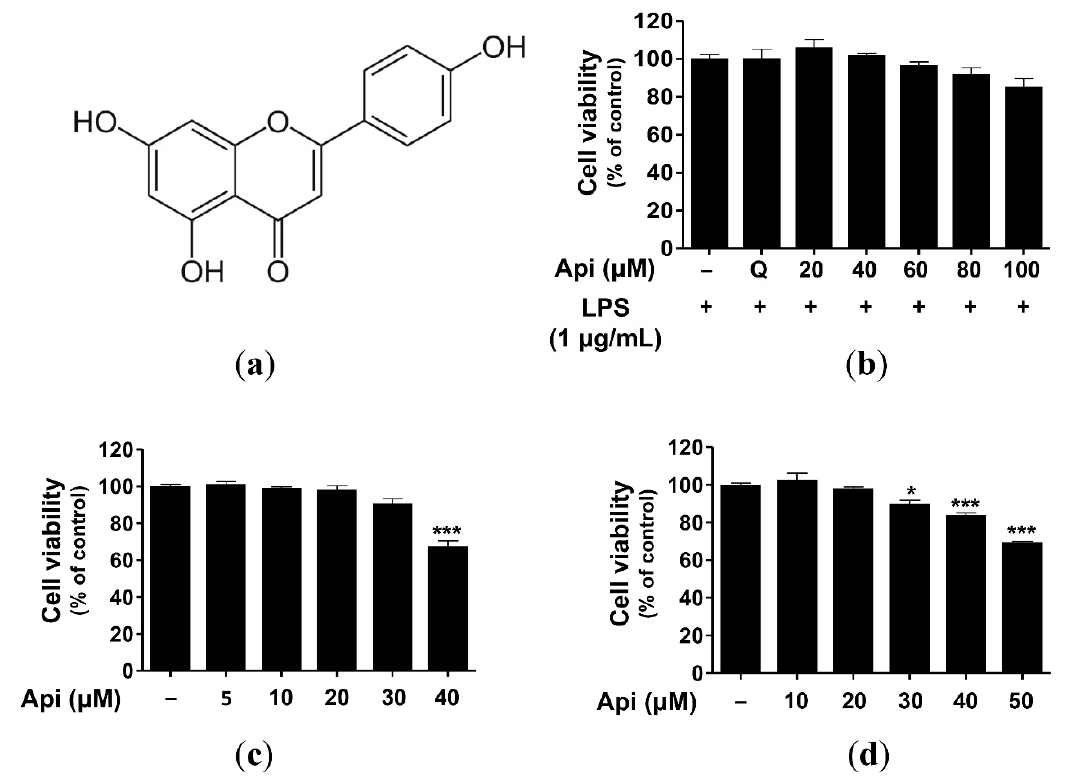
Figure 1. Molecular structure ( a ) and cytotoxic effects of apigenin on RAW264.7 ( b ), RBL-2H3 ( c ), and HaCaT cells ( d ). Cells were treated with various concentrations of apigenin (5, 10, 20, 30, 40, 50, 60, 80, and 100 μ M) for 24 h. The data were analyzed using one-way analysis of variance (ANOVA) followed by Tukey’s test. * p <0.05, *** p <0.001 versus LPS-exposed cells without apigenin treatment. Api, apigenin; LPS, lipopolysaccharide; Q, quercetin (15 μ M).